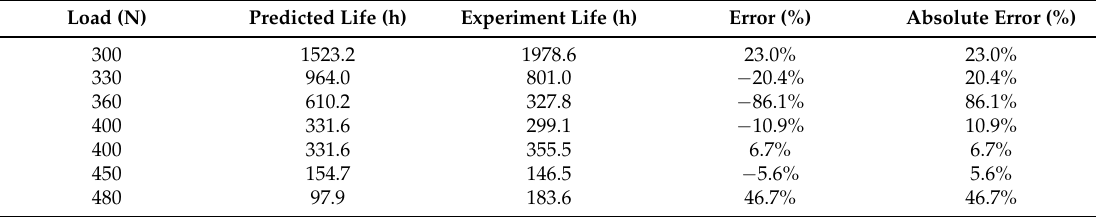
Table 6. The prediction results of 16Mo3 by the Larson-Miller Parameter Method.